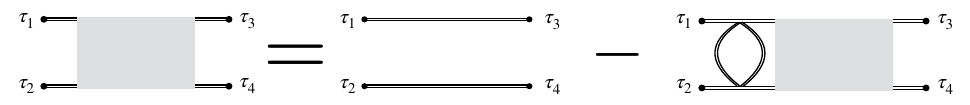
( (cid:28) 1 ; (cid:28) 2 ; (cid:28) 3 ; (cid:28) 4 ). For the theory G